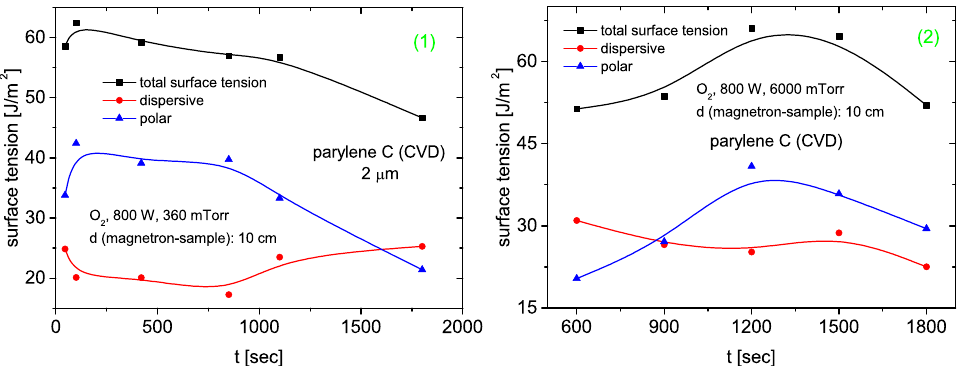
Figure 31. Surface energy of parylene C layers deposited with CVD and subsequent oxygen plasma treatment for two different discharge pressures. ( 1 ): 360 mTorr, ( 2 ): 6000 mTorr. The conduct against water is completely